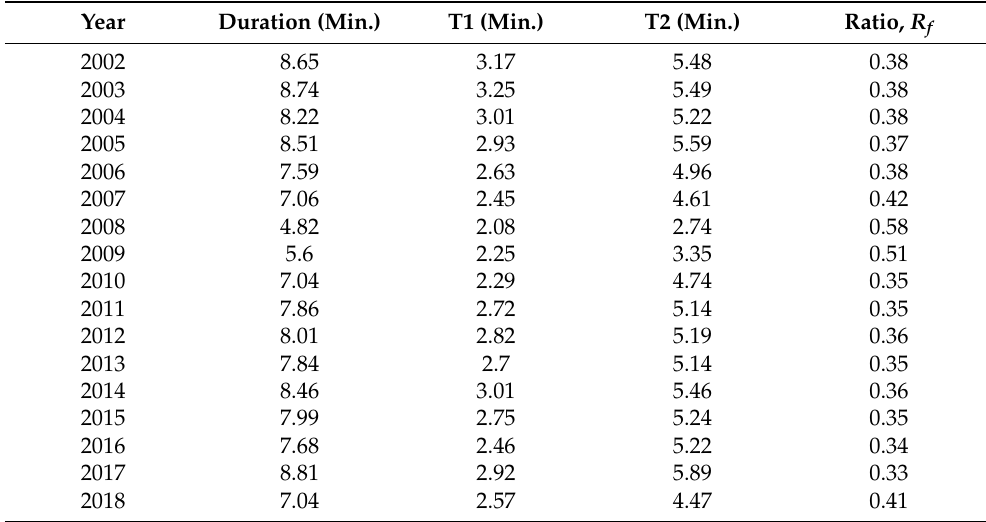
Table 2. The time profile parameters of the RHESSI solar flares during the period 2002–2018. Year Duration (Min.) T1 (Min.) T2